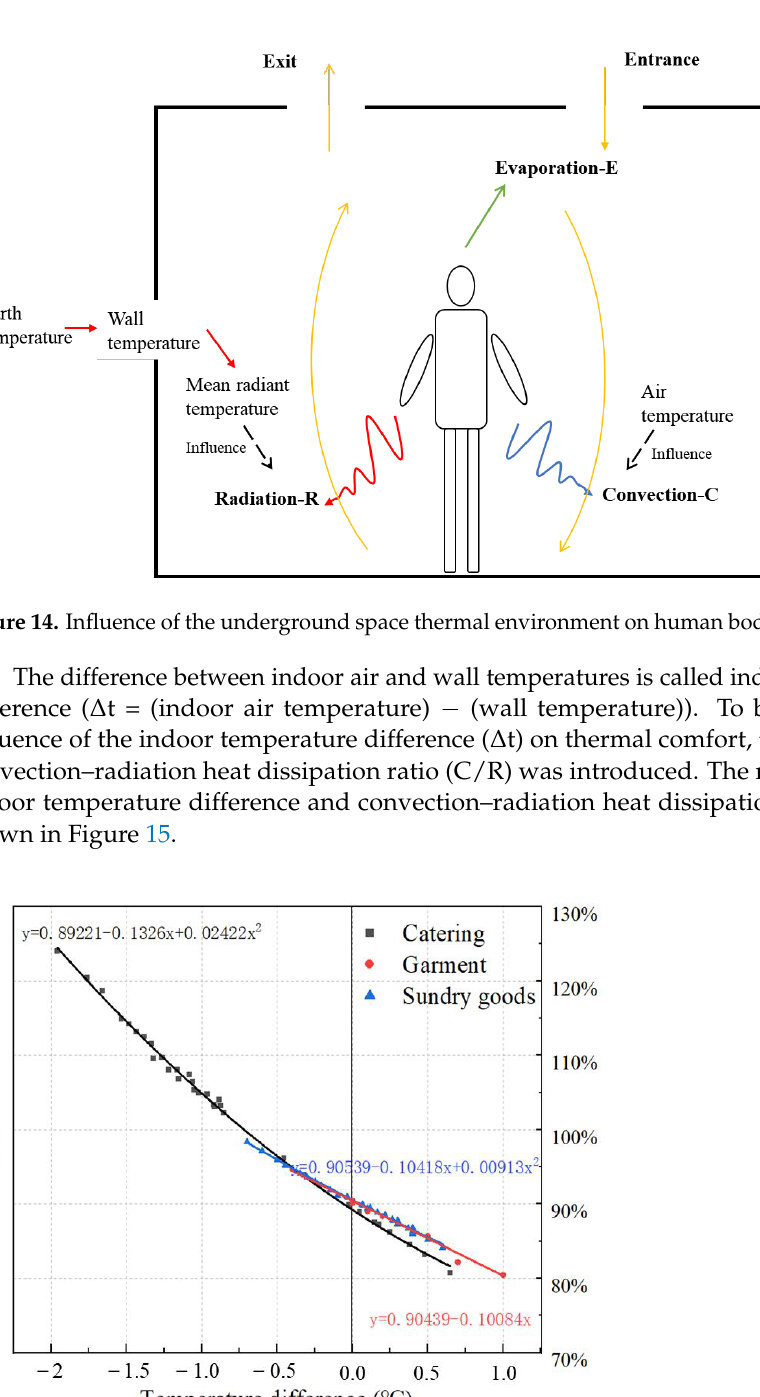
Figure 15. Convection – radiation heat dissipation ratio in different functional areas.